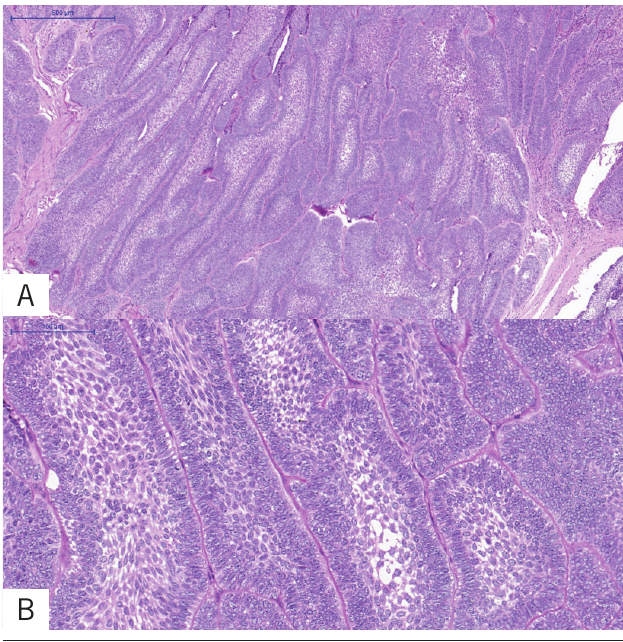
figura 1 − A) múltiplos ninhos e cordões de epitélio odontogênico demonstrando diferenciação colunar periférica com polarização reversa. Zonas centrais assemelham-se a retículos estrelados (HE, 500 µm); B) magnificação mais alta destaca as células colunares periféricas exibindo polarização reversa (HE, 100 µm) HE: hematoxilina e